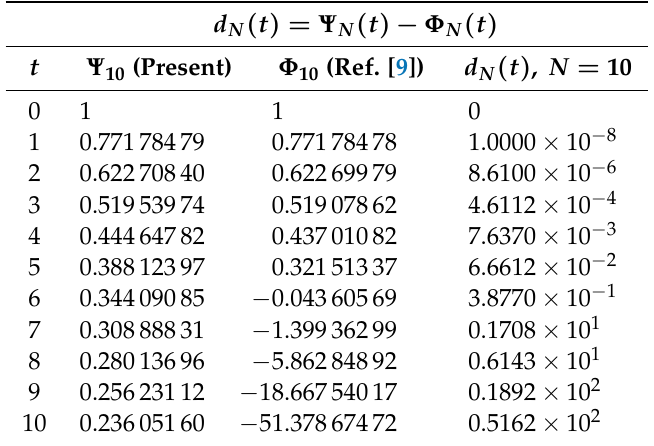
Table 2. Comparison between the present results and Picard iterative method [9] when λ = 1, q = 1.4 and α = 1.